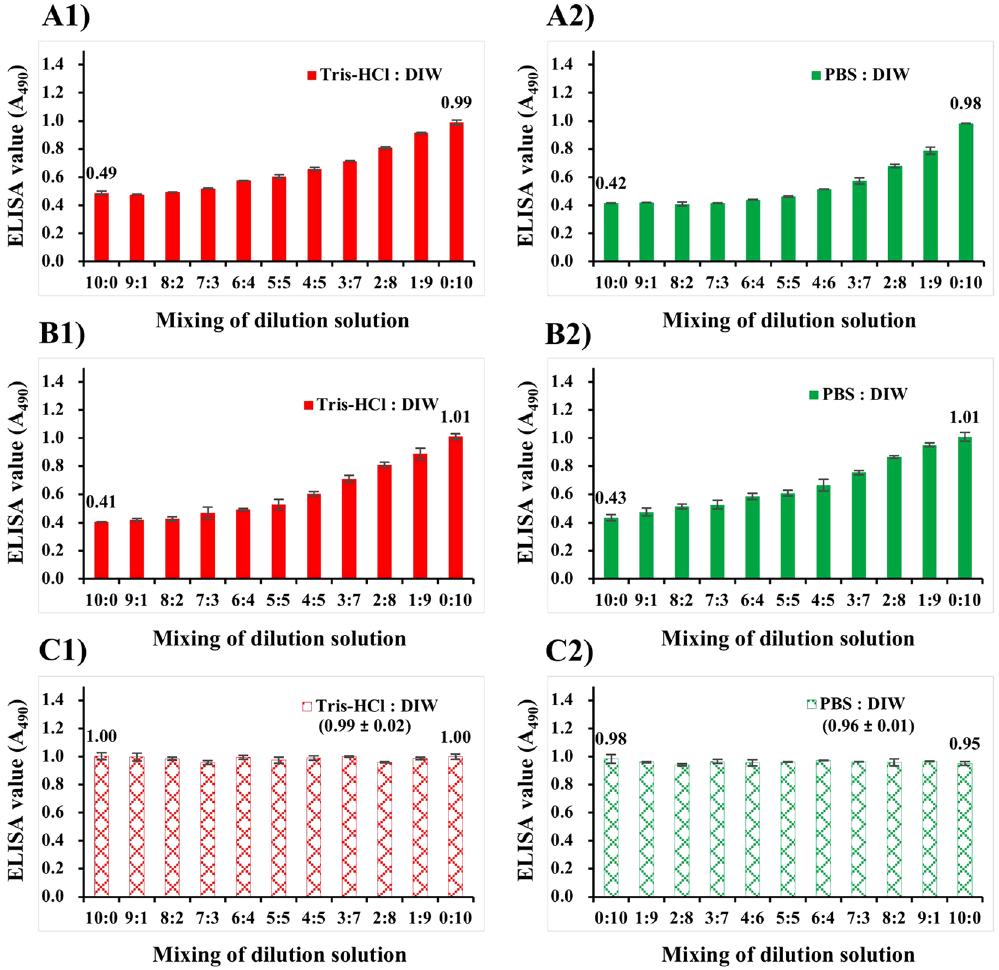
Figure 5. Influence of dry-immobilization on NNV antigenicity. NNV antigens diluted with Tris-HCl or PBS were mixed with those diluted with DIW at different ratios ranging 10:0 to 0:10. These mixed NNV antigens were subsequently immobilized to ELISA plate wells by drying at 37 °C overnight. ( A ) Cultured NNV suspensions diluted with DIW, Tris-HCl, or PBS were mixed at different ratios. ( B ) Purified NNV particles in Tris- or PBS-diluted L-15 10 media were respectively mixed with those suspended in DIW-diluted L-15 10 medium at different mixing ratios. ( C ) NNV particles suspended in Tris-HCl or PBS were respectively mixed with those suspended in DIW at different mixing ratios. Error bars indicate standard deviation